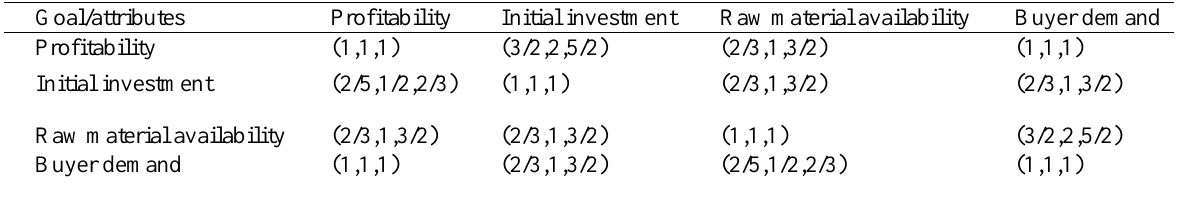
Table 5. The fuzzy evaluation matrix with respect to goal with triangular fuzzy numbers.